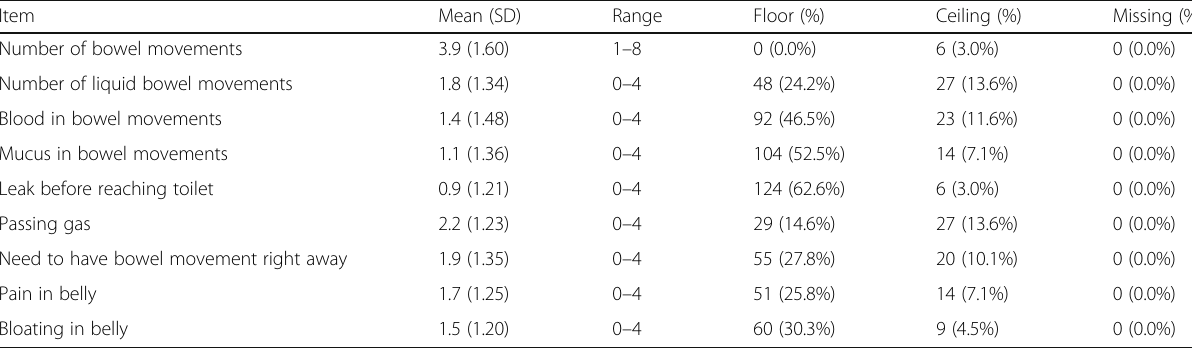
Table 2 Item Descriptive Characteristics at Worst Day between Visit 1 and Visit 2 ( N =